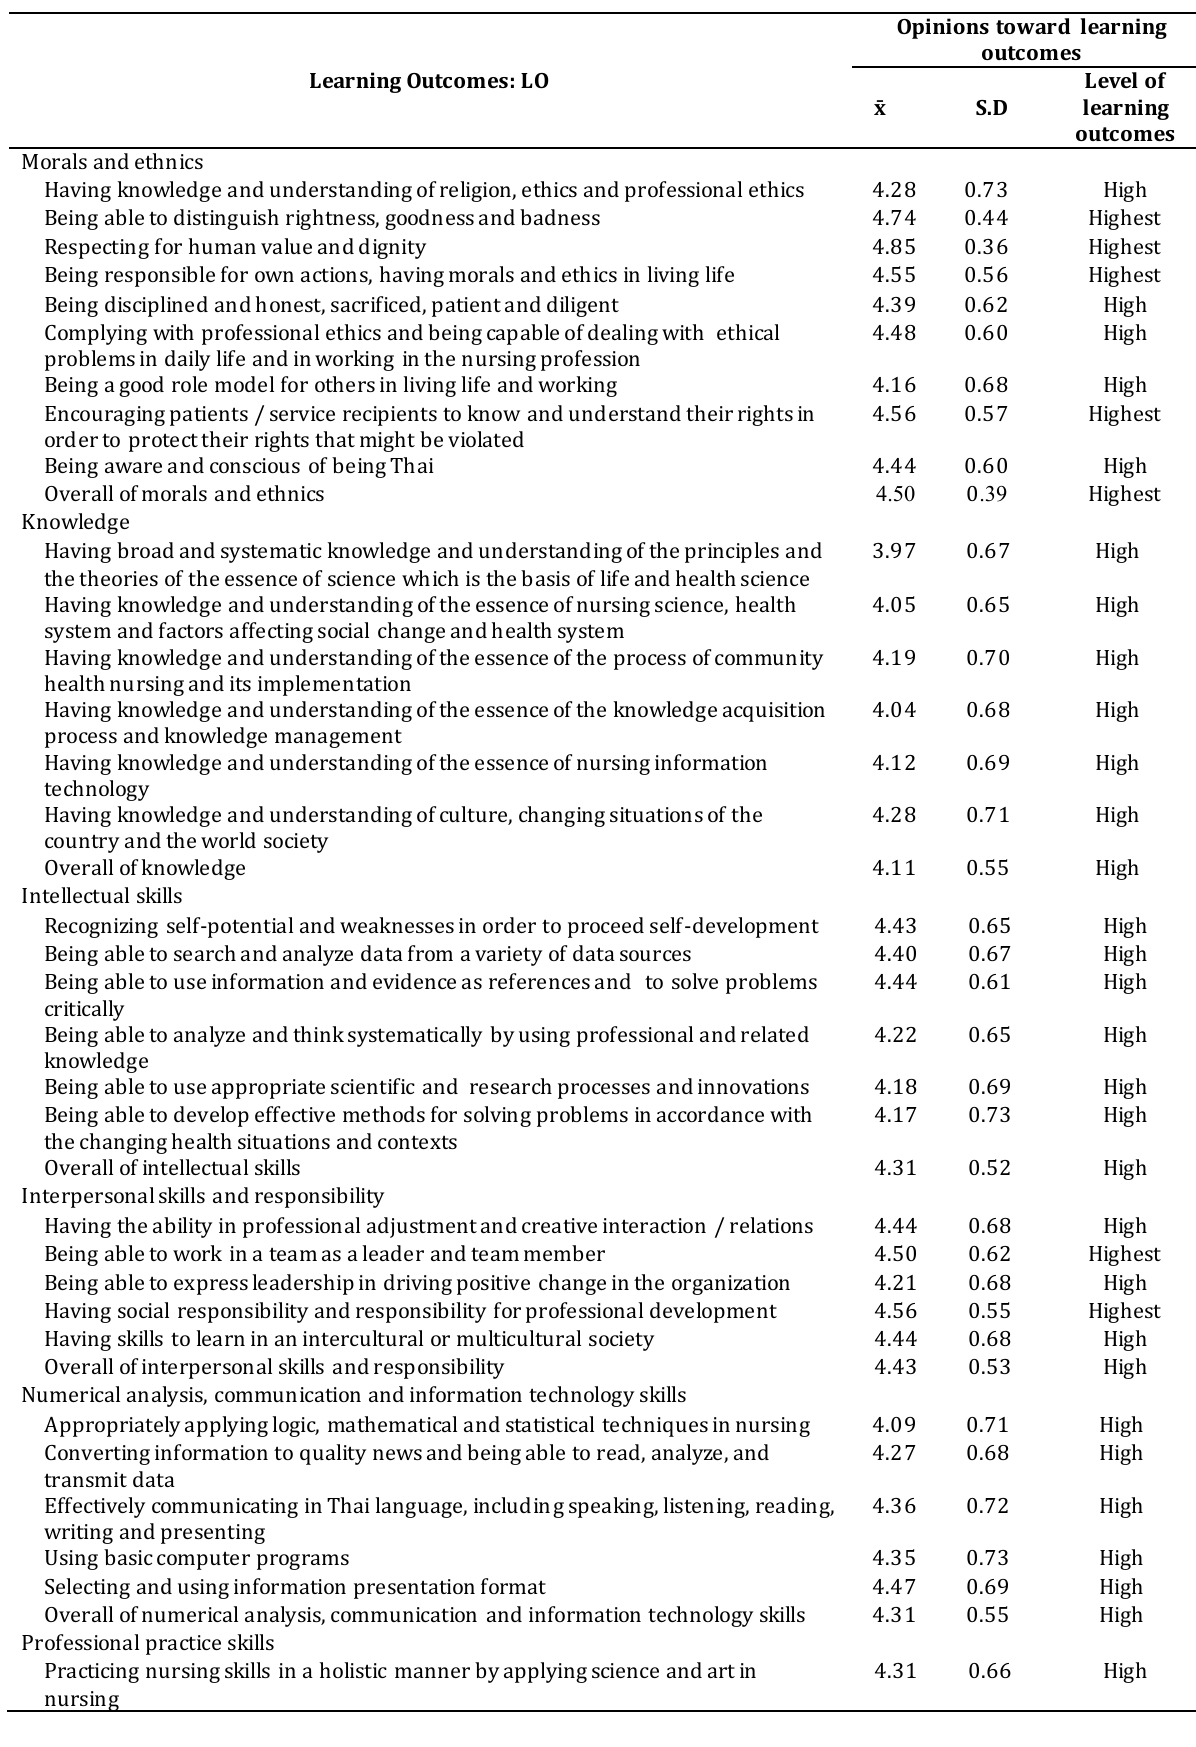
Table 2: Learning outcomes according to the Thai Qualifications Frameworks for Higher Education of Community Health Nursing Practicum Course, the Faculty of Nursing, Naresuan University ( n= 1 13